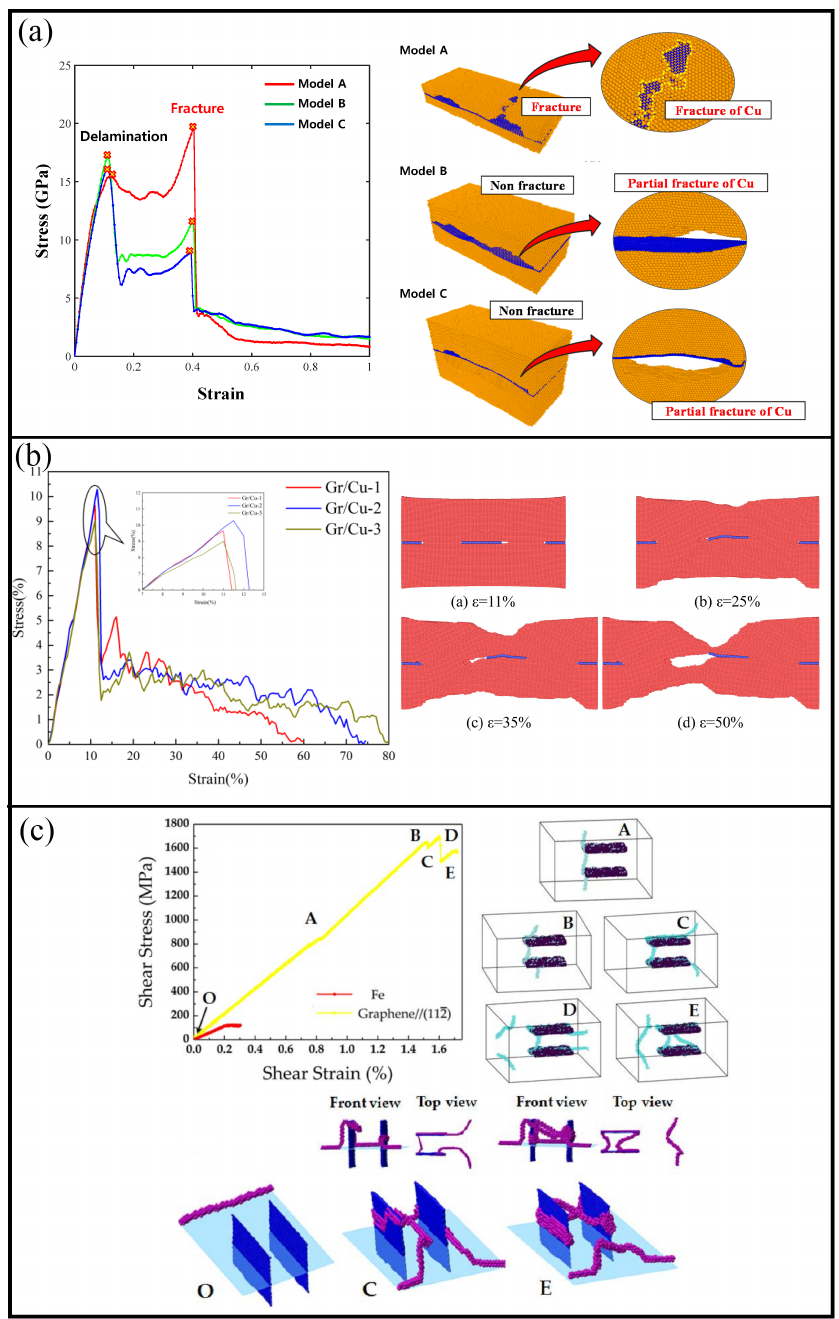
Figure 6. ( a ) Stress–strain curves for Cu/graphene composite during uniaxial tension along the zigzag direction of graphene with the snapshots of the structure at the fracture point. Three different thicknesses of the Cu part are considered: Model A (4.8 nm), Model B (9.8 nm), and Model C (14.3 nm). Reprinted with permission from [153]. ( b ) Stress–strain curves during tension for structures with different coverage and arrangement of graphene (Gr/Cu-1, Gr/Cu-2, and Gr/Cu-3, respectively). The snapshots of the Gr/Cu-1 composite during tension are presented. Reprinted with permission from [155]. ( c ) Stress–strain curves of the pure iron and the graphene/Fe composite. A pair of single- layer graphene nanoribbons at different locations in the metal matrix is used as the reinforcement. Reprinted with permission from